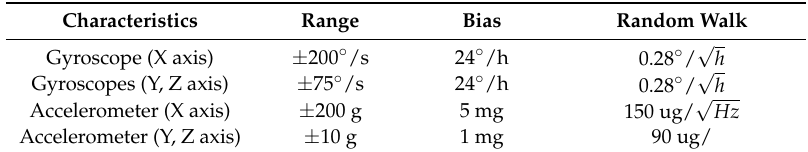
Table 3. Characteristics of